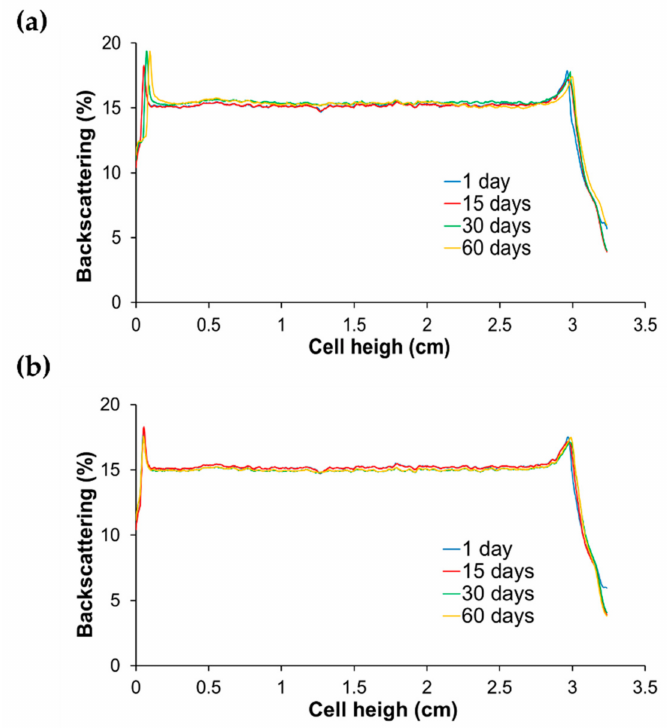
Figure 3. Backscattering profiles of bLF-LIP stored at: ( a ) 4 ◦ C and ( b ) 25 ◦